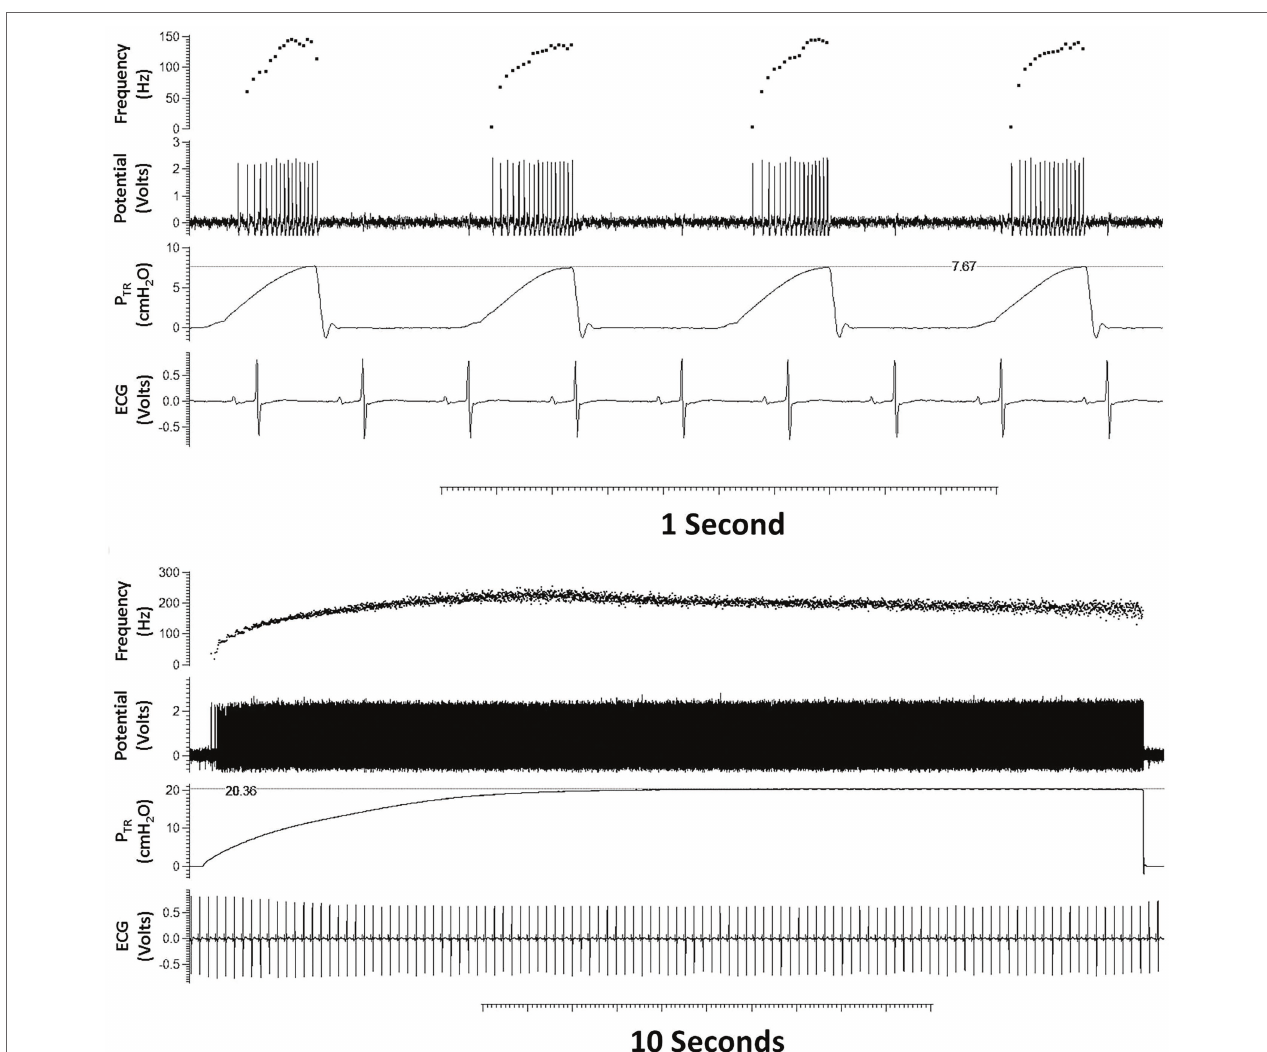
FIGURE 2 | Typical tracing of a single slowly adapting receptor (SAR) during tidal breathing (top panel) and quasi-static inflation to 20 cmH 2 O (bottom panel) . From top to bottom within each panel are shown: AP f (AP/s), action potentials [Potential (Volts)], trans-respiratory pressure (P TR ), and heart rate [ECG (Volts)]. The SAR demonstrates characteristic augmenting discharge frequency during tidal inflation (upper panel) and sustained discharge frequency at a maintained pressure (bottom